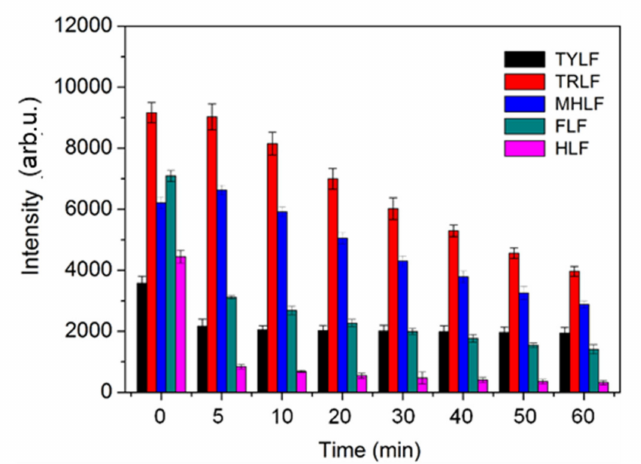
Figure 4. Distributions of the abundance of the dissolved organic matter (DOM) components in UV / O 3